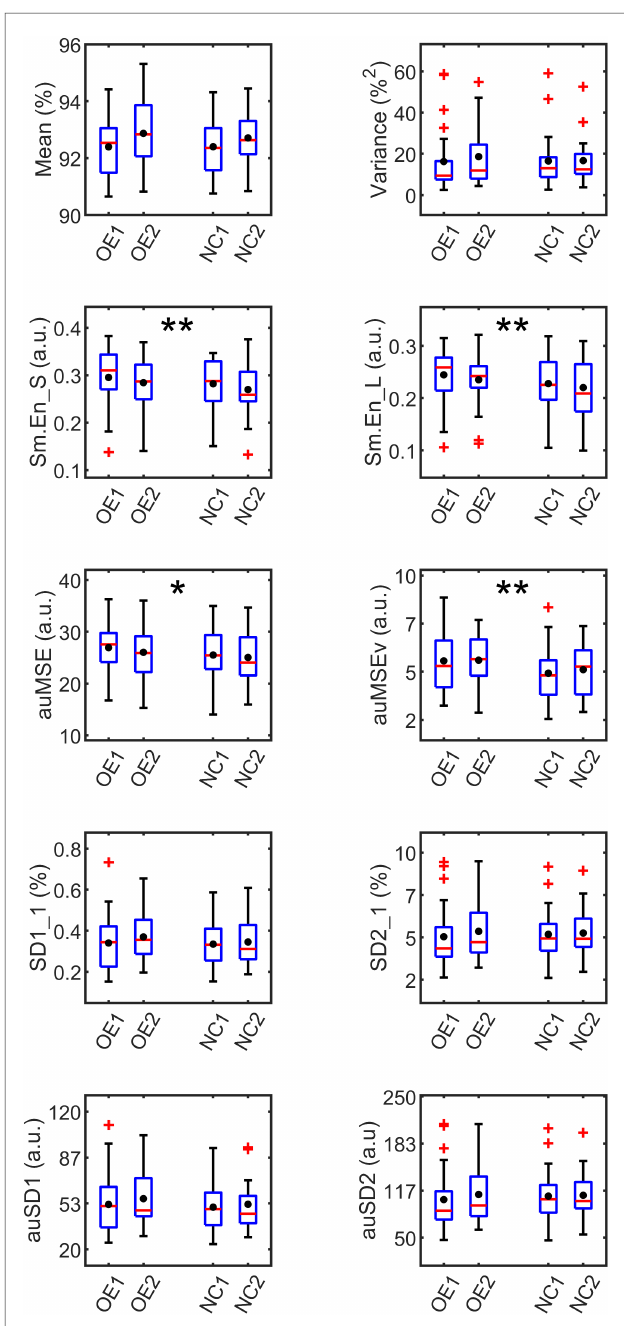
FIGURE 4 Boxplots of SpO 2 measures averaged over 24 h grouped by supplementation. OE1,2 and NC1,2 refer to fi rst and second applications of oxygen environment (OE) and nasal cannula (NC) treatments respectively. The red line in each box represents the median, and the black circle, the mean of the measure. The outliers (red markers) are values more than 1.5 times the interquartile range. The box whiskers extend to the most extreme value not considered an outlier. Signi fi cant differences from mixed linear analysis observed between treatments OE and NC are marked as * p <0.05, ** p